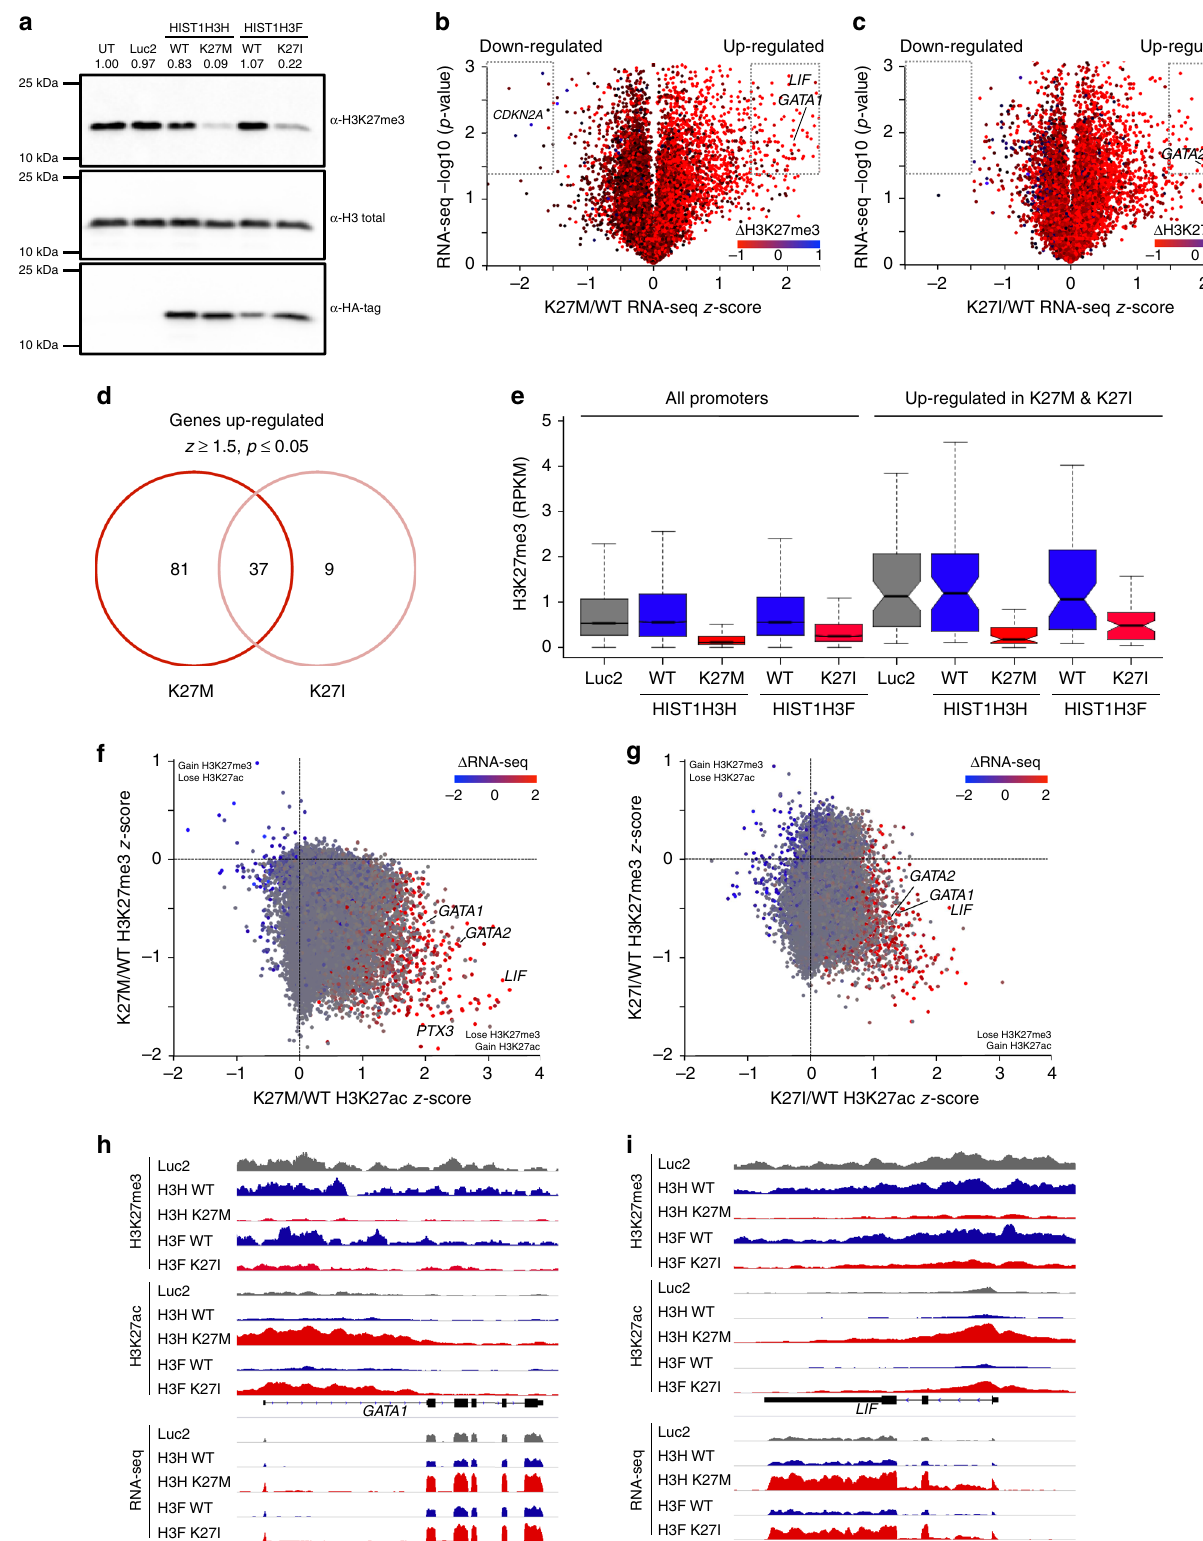
H3K27ac ChIP-seq results with RNA-seq and H3K27me3 in TEX cells showed that loss of H3K27me3 was not concomitant with H3K27ac gain per se . Rather, the promoters of upregulated genes, such as GATA1 and LIF , have higher H3K27ac (Fig. 3f – i). Thus, global loss of the repressive H3K27me3 in H3.1 K27 mutants